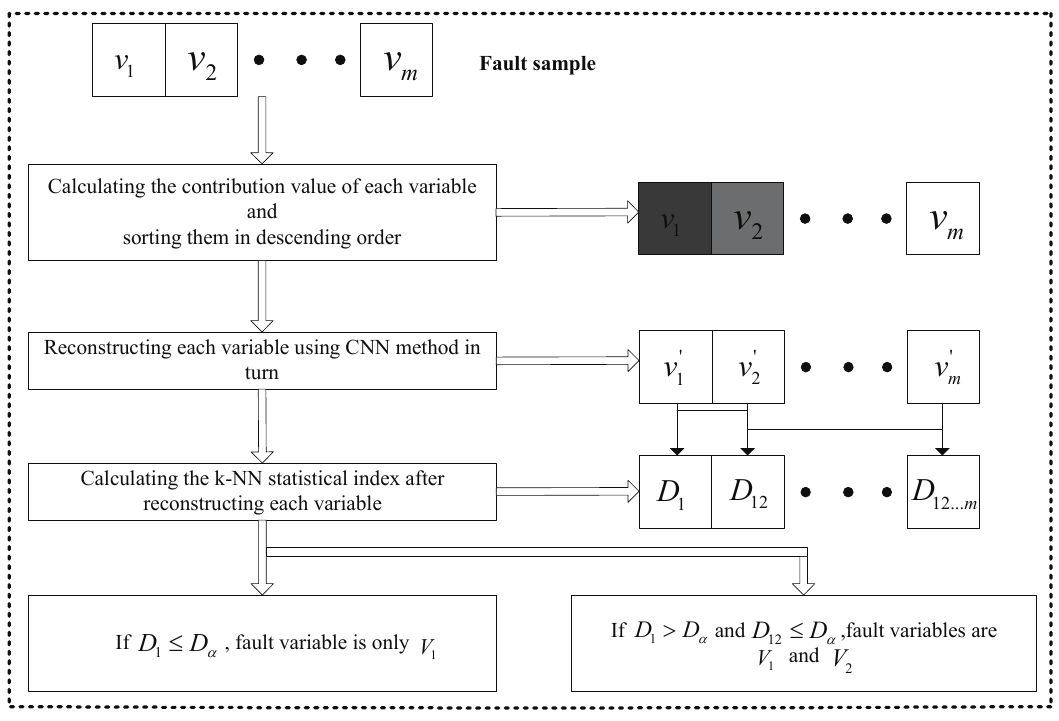
Figure 4. Flowchart of faulty variable